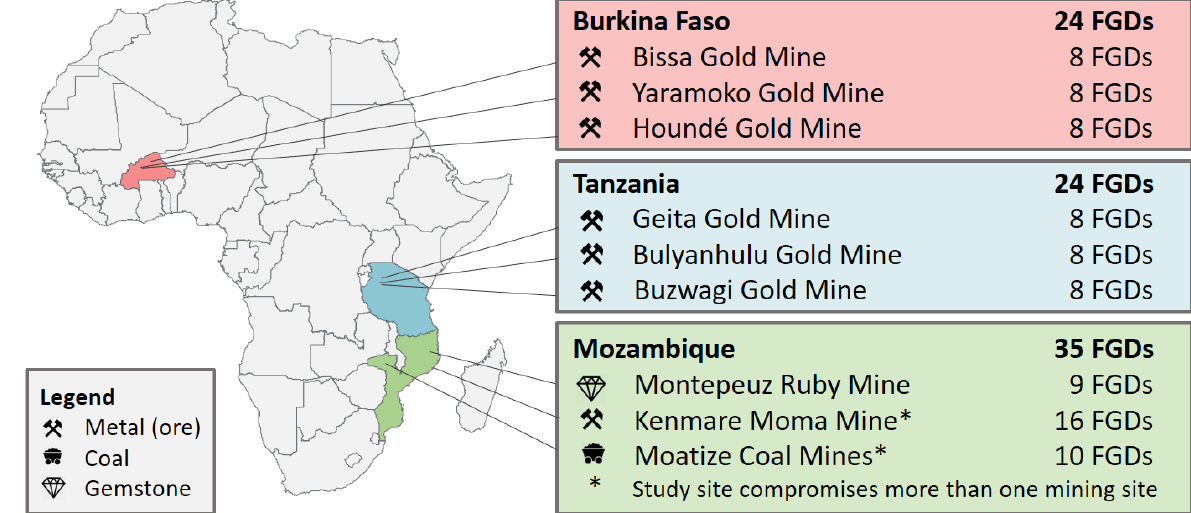
Figure 1. Overview of study sites in three African countries, indicating location, the type of mining project, and the number of focus group discussions (FGDs) conducted.